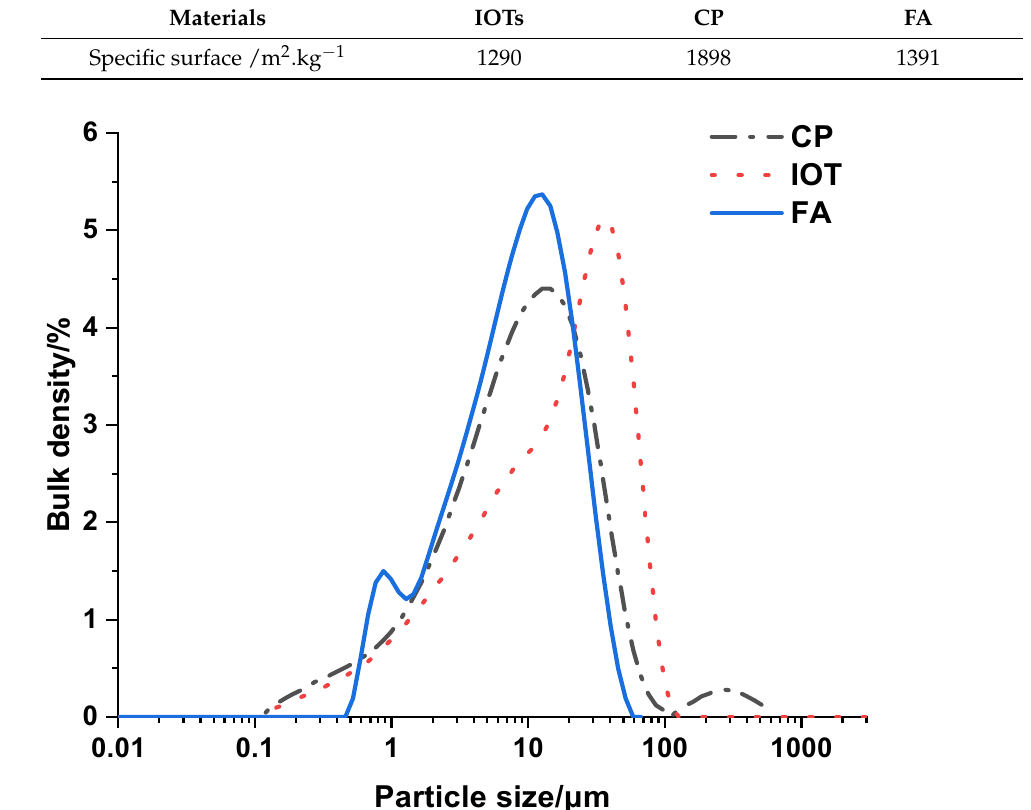
Table 3. Cement mortar ratio of group